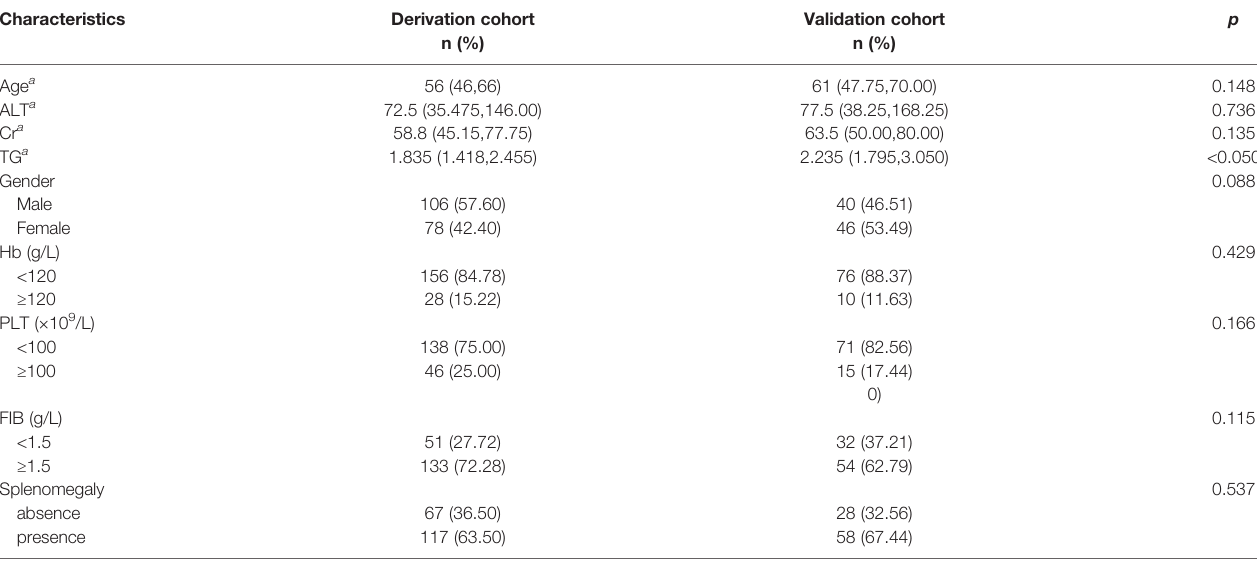
TABLE 1 | Basic clinical information of adult